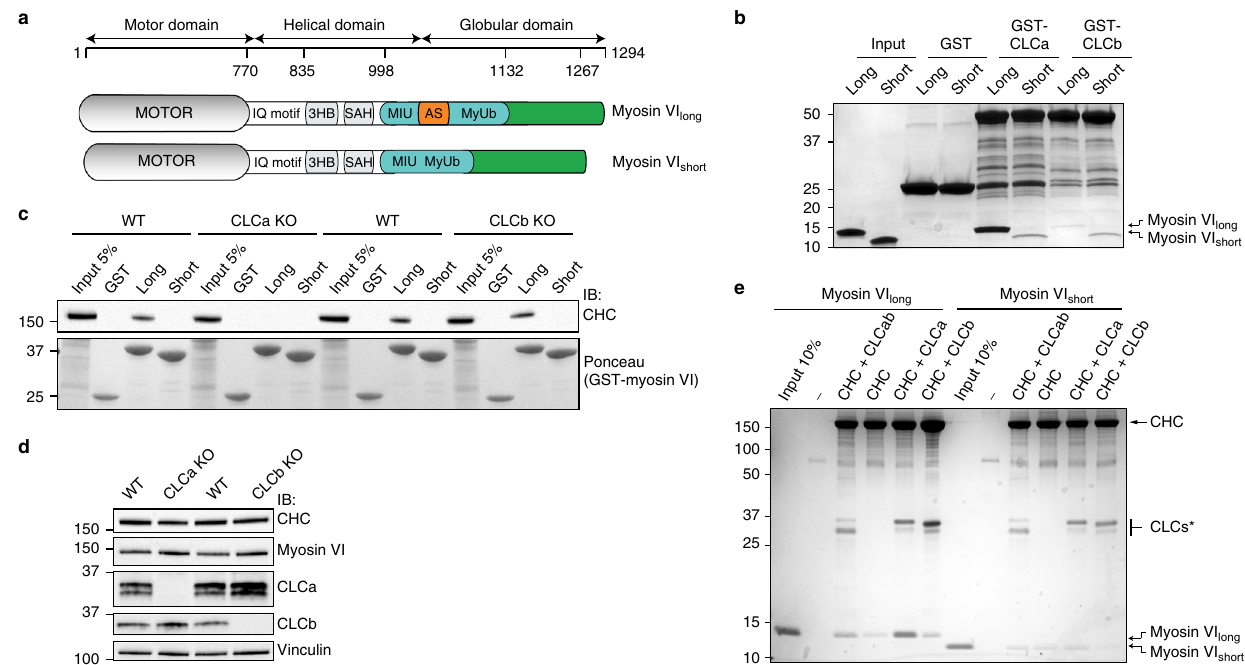
Fig. 1 CLCa is a direct and speci fi c interactor of myosin VI long in triskelia and clathrin cages. a Scheme of the myosin VI highlighting the region involved in clathrin binding (amino acids 998 – 1131 of the long isoform). Long and short isoforms are reported together with the domains and motifs previously identi fi ed, including IQ motif, 3HB (three-helix bundle), SAH (single α -helix), MIU (motif interacting with ubiquitin), AS (alternative splicing region), and MyUb (myosin VI ubiquitin-binding domain). In orange is represented the alternatively spliced region codifying for the α 2-linker 18 . b Pull-down assay with GST-CLCa and CLCb full-length and cleaved and puri fi ed fragments spanning amino acids 998 – 1131 of long and short myosin VI isoforms. Glutathione sepharose beads coupled to GST and GST-tagged proteins were incubated with myosin VI 998 – 1131 . After washes, bound proteins were eluted in Laemmli- buffer, resolved through SDS-PAGE, and stained with Coomassie. c Pull-down assay using the long and short GST-myosin VI 998 – 1131 constructs and brain lysates (500 μ g) obtained from the indicated mouse strains. After washes, bound proteins were eluted in Laemmli-buffer, resolved through SDS-PAGE, and transferred to a nitrocellulose membrane. Immunoblot (IB) was performed with anti-clathrin heavy-chain antibody. Ponceau detect equal loading of GST proteins. d IB of the brain lysates used in ( c ), as indicated. e Co-sedimentation assay. Equimolar (1.5 μ M) amount of myosin VI 998 – 1131 and clathrin cages were incubated at 4 °C for 45 min in the presence of detergent (0.1% Triton X-100) and then pelleted by ultracentrifugation. Precipitated proteins were dissolved in Laemmli-buffer, resolved through SDS-PAGE, and stained with Coomassie. CLCs* indicates the various CLC proteins. Note that in the native cages CLCs (CHC-CLCab) run at different molecular weight (mw) as they are from pig brain while the human CLCs used for reconstitution are bacterially produced and cleaved from